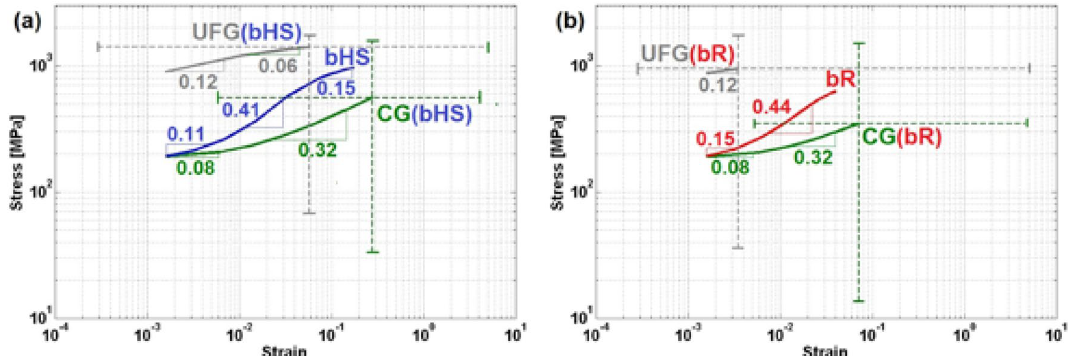
Figure 6. Mean true stress σ eff vs. true strain ε eff curves in log–log scale for the simulated ( a ) bHS and ( b ) bR materials. The curves represent the computed stress–strain dependencies separately for each CG and UFG phase and the entire material volume, while dash-line bars show ranges of stress and strain at ultimate tensile strength (initiation of strain localisation). The numerical values indicate strain hardening coefficients for each material and phases within at different stages of plastic